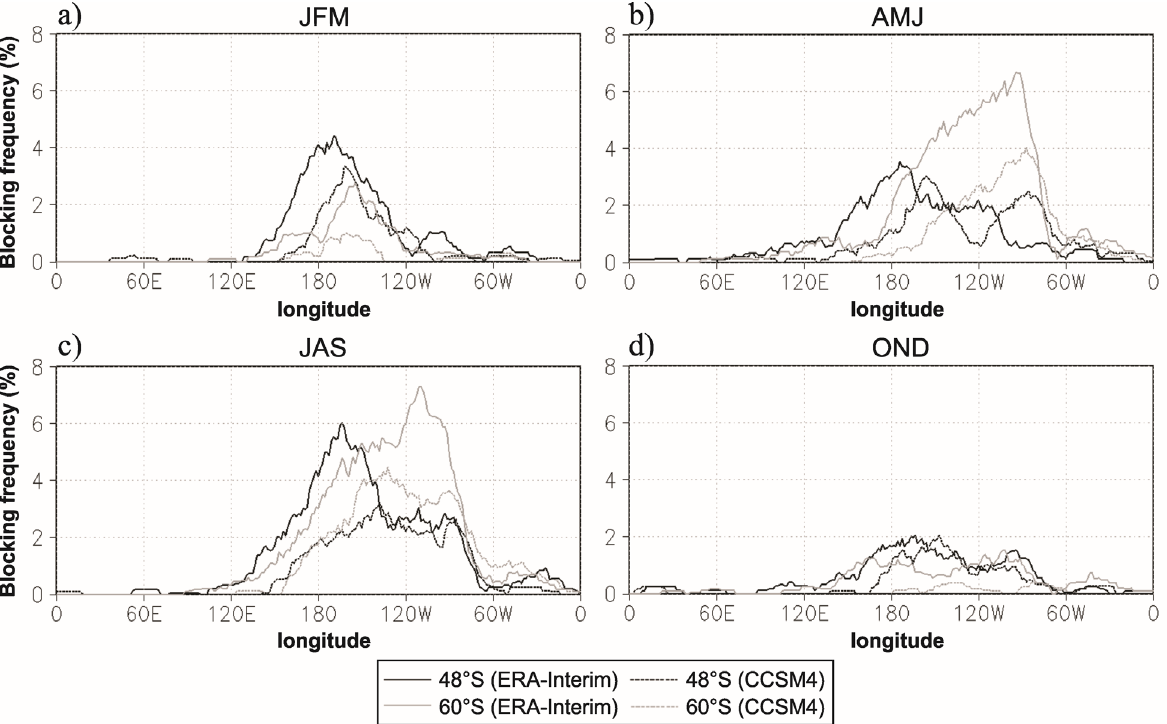
Figure 4. Seasonal frequency of blocking events by longitude (%) in the ERA-Interim reanalysis (continuous lines) and in the CCSM4 historical experiment (dashed lines) during (a) summer (JFM), (b) autumn (AMJ), (c) winter (JAS) and (d) spring (OND) over